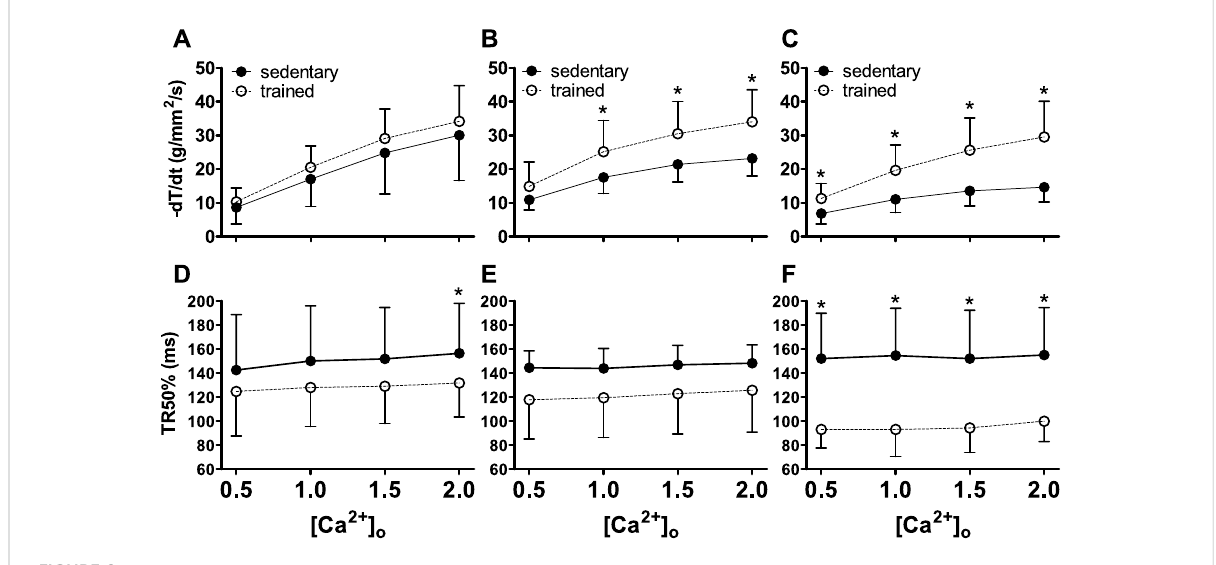
FIGURE 2 Lusitropic function ( − dT/dt and TR50%) of sedentary rats (solid symbols) and trained rats (empty symbols) with different myocardial infarction size after swimming exercise training. Lusitropy was evaluated by different extracellular calcium concentrations [(Ca 2+ ) o ]. The myocardial infarction size:Shamoperated (A,D) ,ModerateMI (B,E) ,andLargeMI (C,F) .Comparisonsbetweensedentaryandtrainedrats:* p < 0.05.Valueswereexpressed by mean ± SD.